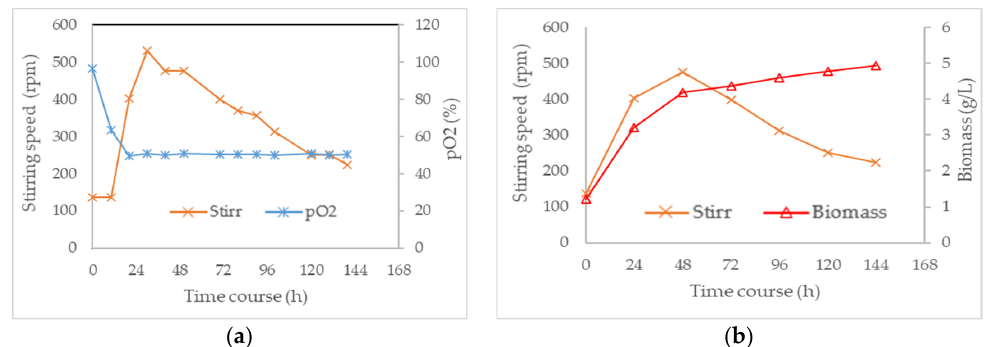
Figure 4. ( a ) Maintenance of 50% dissolved oxygen over time (0 to 168 h) in a submerged culture of T. albobiverticillius 30548 in a 2 L bioreactor showing the variation of stirring speed over time (0 to 160 h); ( b ) effect of agitation speed over time (0 to 160 h) on biomass production in a submerged culture of T. albobiverticillius 30548 in a 2 L bioreactor in combination with dissolved oxygen (pO 2 ) at 50%.